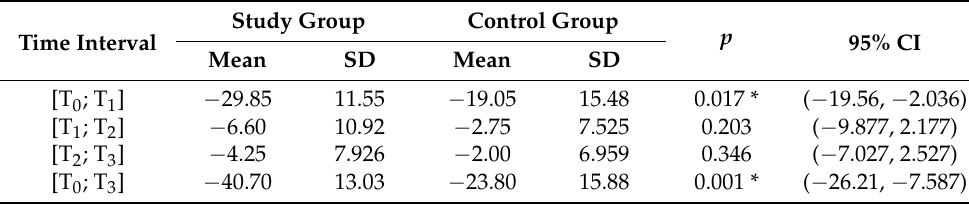
Table 3. Comparison of Plaque Index changes. Mean and SD in percentage points.